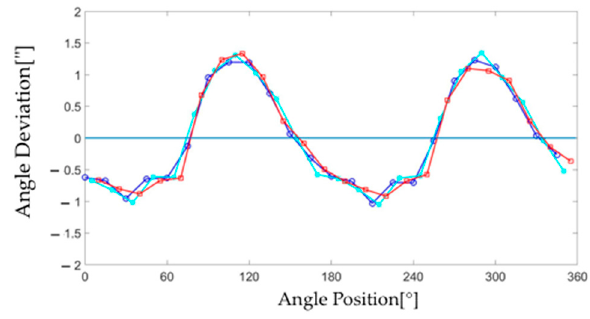
Figure 6. Calibration results for pitch angle deviations of the 24-faced polygon.